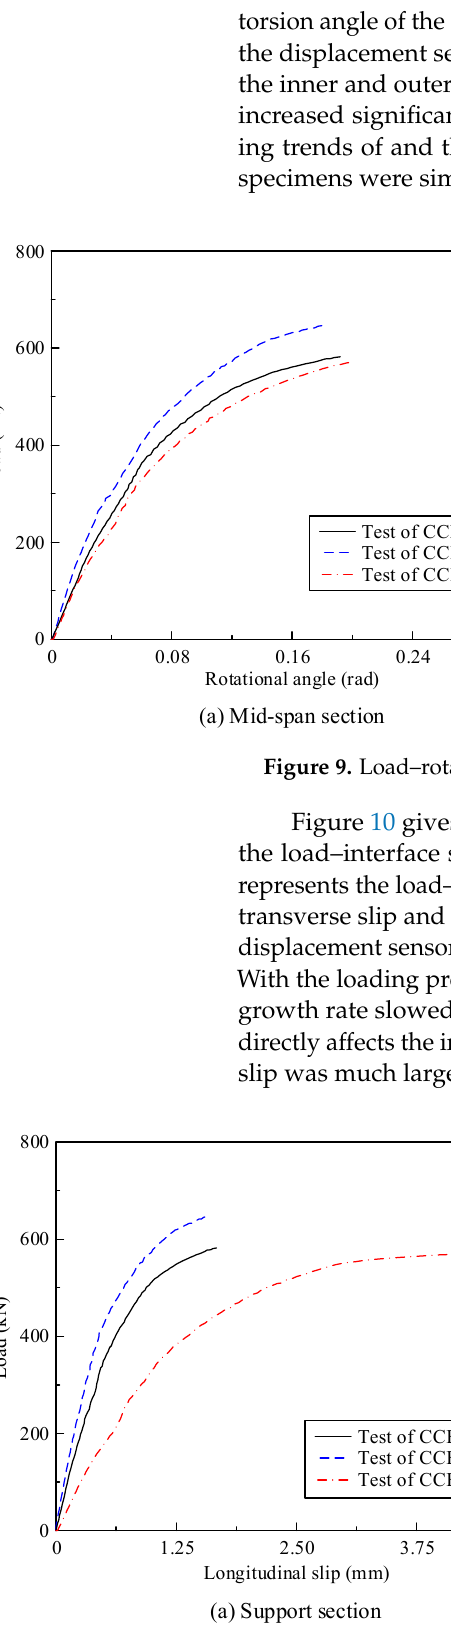
Figure 10. Load–interface slip curves of the test specimens.